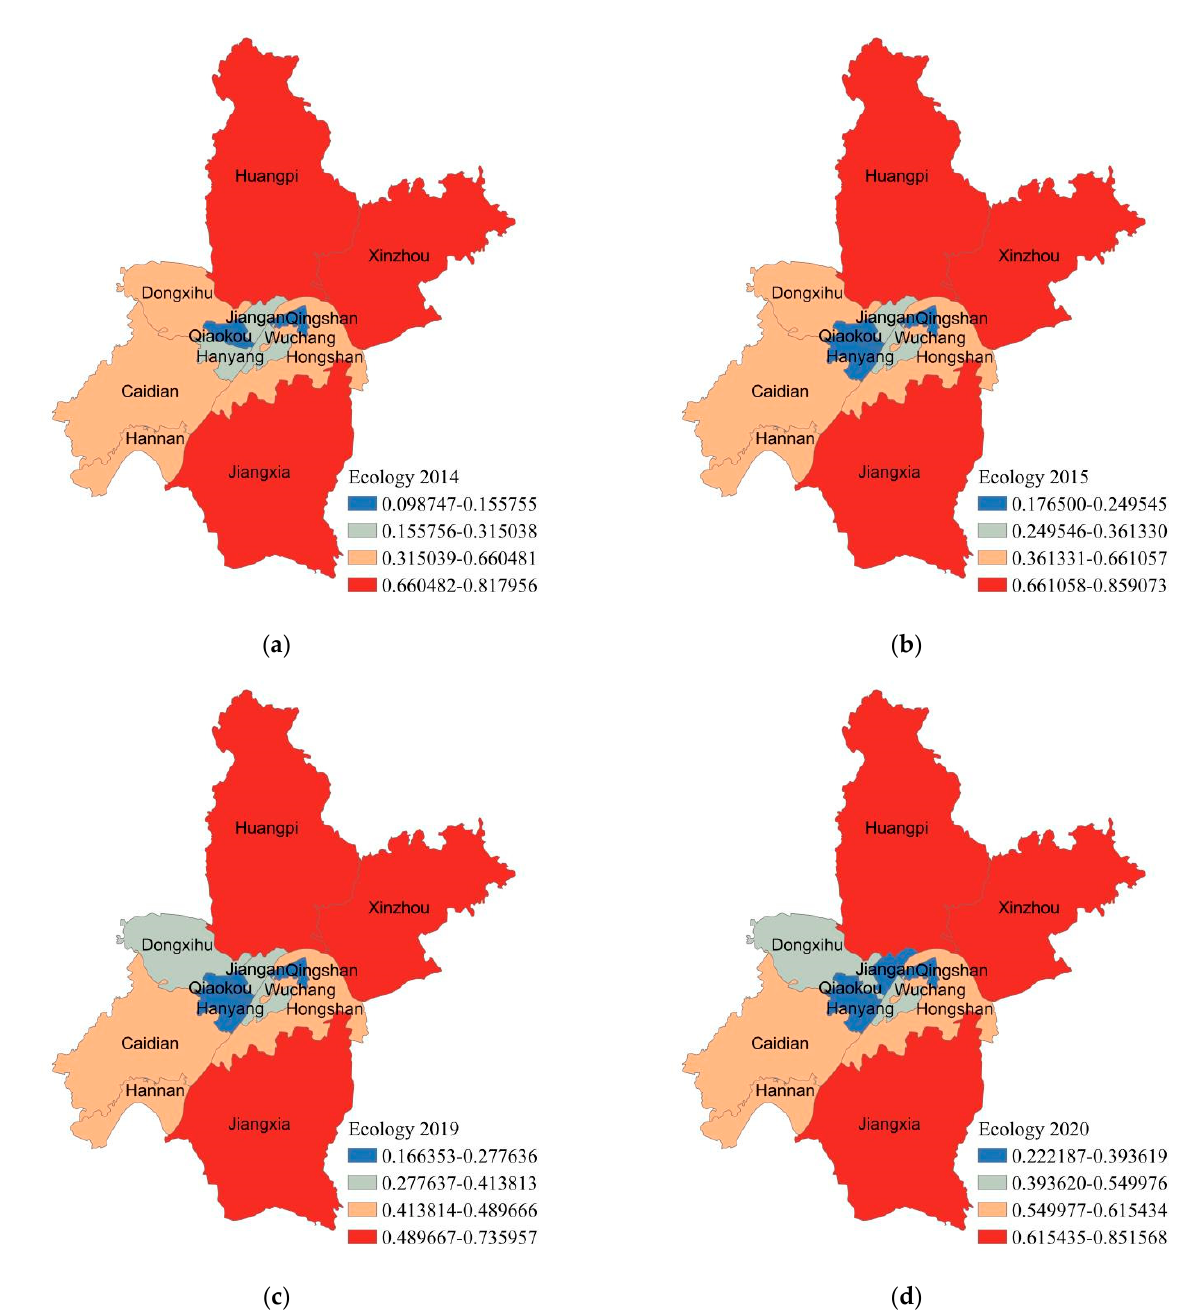
Figure 4. Quartile map of ecological level of Wuhan city. ( a ) 2014. ( b ) 2015. ( c ) 2019. ( d ) 2020.